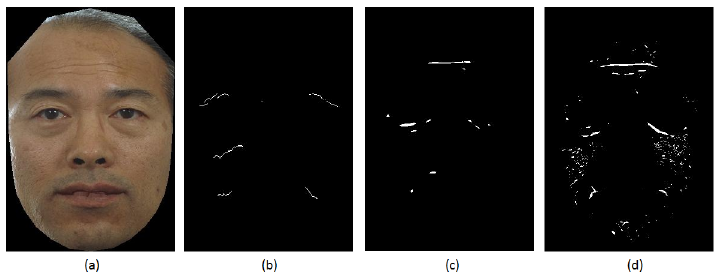
Figure 7. A comparison between the wrinkle detection results of three methods: ( a ) Original image; ( b ) Gabor Filter; ( c ) HHF; and ( d ) Enhancement method.